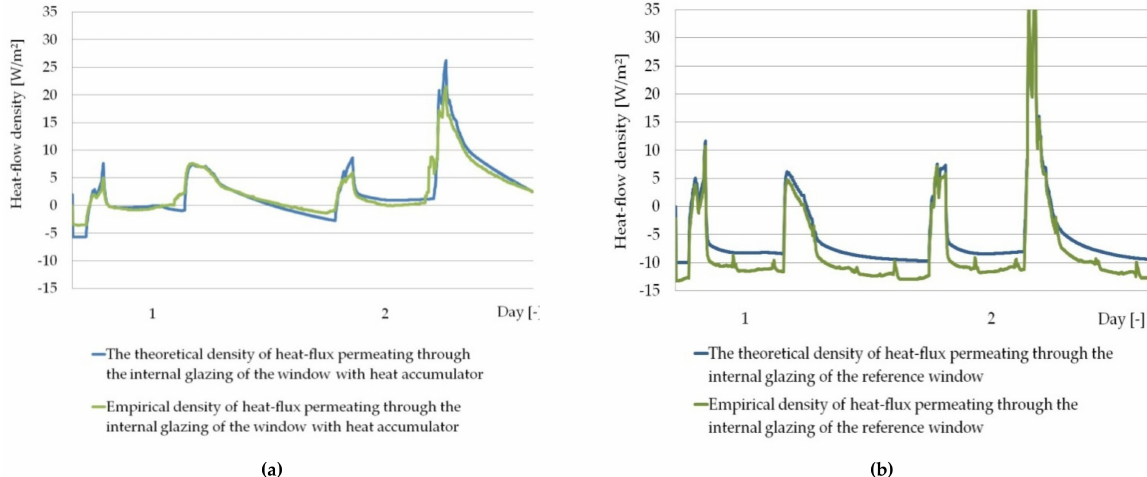
Figure 11. ( a ) Graphs of the measured and modelled heat flux density at the internal glazing surface of the window with the PCM heat accumulator; ( b ) Graphs of the measured and modelled heat flux density at the internal glazing surface of the reference window.